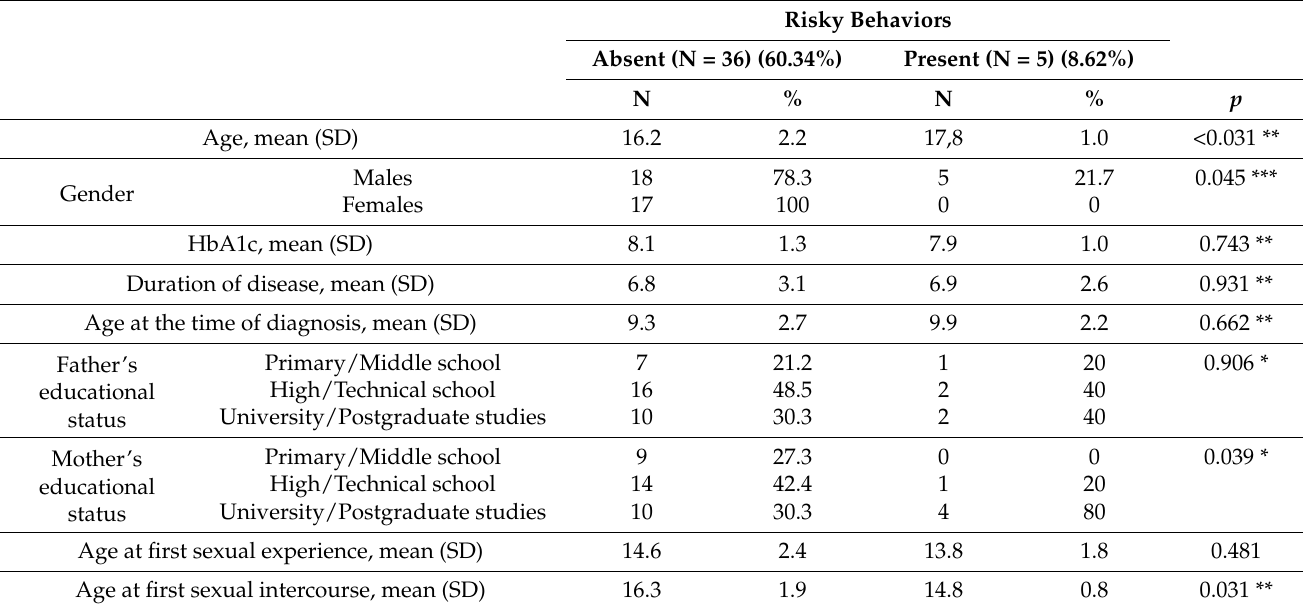
Table 4. Characteristics of T1D adolescents according to the presence/absence of two or more risky